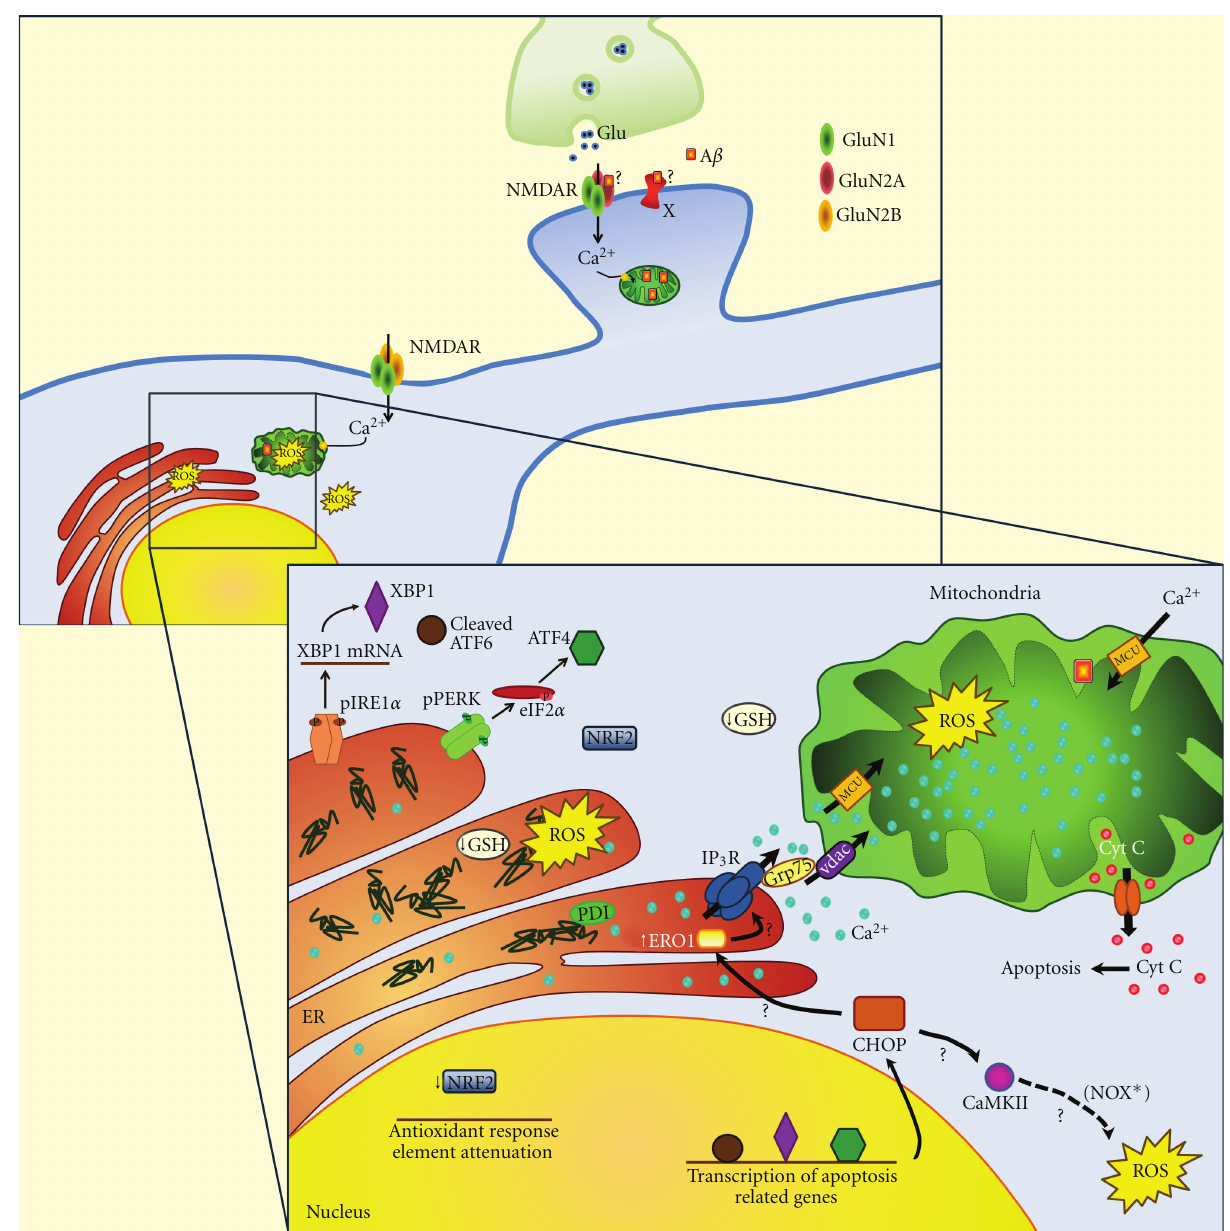
Figure 1: Sources of reactive oxygen species in Alzheimer’s disease. Extracellular accumulation of A β may direct or indirectly alter NMDARs- mediated glutamatergic neurotransmission with concomitant cytosolic Ca 2+ increase and impaired synaptic activity. Excitotoxic increase in glutamatergic neurotransmission may activate extrasynaptic NMDARs leading to a massive increase in the intracelular Ca 2+ , which is rapidly taken up by mitochondria and ER. Mitochondria Ca 2+ overload promotes the generation of ROS. Additionally, the ER may also promote ROS production. Decreased PDI activity may lead to polyubiquitinated proteins accumulation, which may thus induce the UPR, mediated by IRE1 α , PERK, and ATF6 pathways. In order to cope with the need to balance disulfide bond formation, the activity of ERO1 α is increased leading to the production of ROS that are able to directly attack and a ff ect IP 3 R function. Since the ER and the mitochondria are in close proximity, the Ca 2+ released from the ER, through the IP 3 R, can then enter directly into mitochondria, through the VDAC or the MCU, leading to the increase in mitochondrial Ca 2+ content, inducing mitochondrial ROS production. As a result of prolonged ER stress, CHOP may induce ERO1 α upregulation or activate the enzyme CaMKII, which can further activate NOX, localized at the plasma membrane, enhancing cytosolic ROS production. As a consequence, protective antioxidant defenses such as GSH are depleted. In addition, Nrf2, which normally translocates to the nucleus where it activates the antioxidant response element, may be retained in the